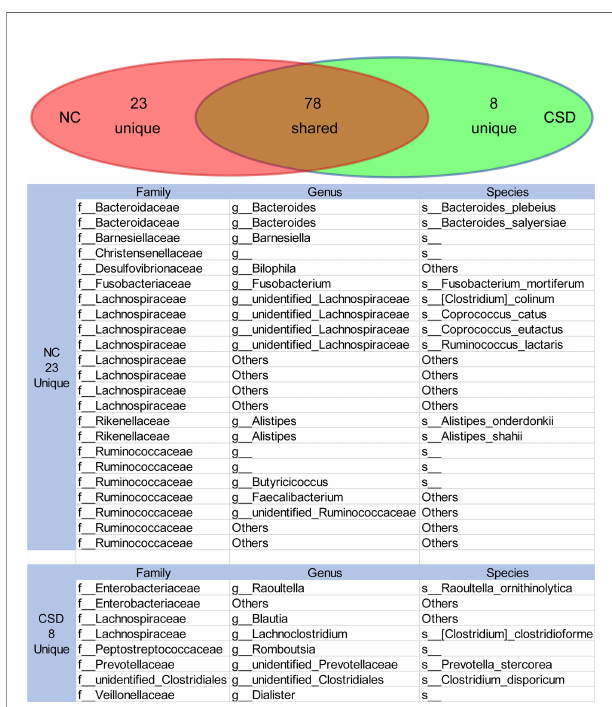
FIGURE 4 | The shared or unique OTUs between the NC group and CSD group were in the core microbiota analysis. Core microbiota is de fi ned as OTUs that exist in more than 90% of individuals with an average relative abundance greater than 0.1%. CSD, chronic spontaneous urticaria and symptomatic dermographism; NC, normal